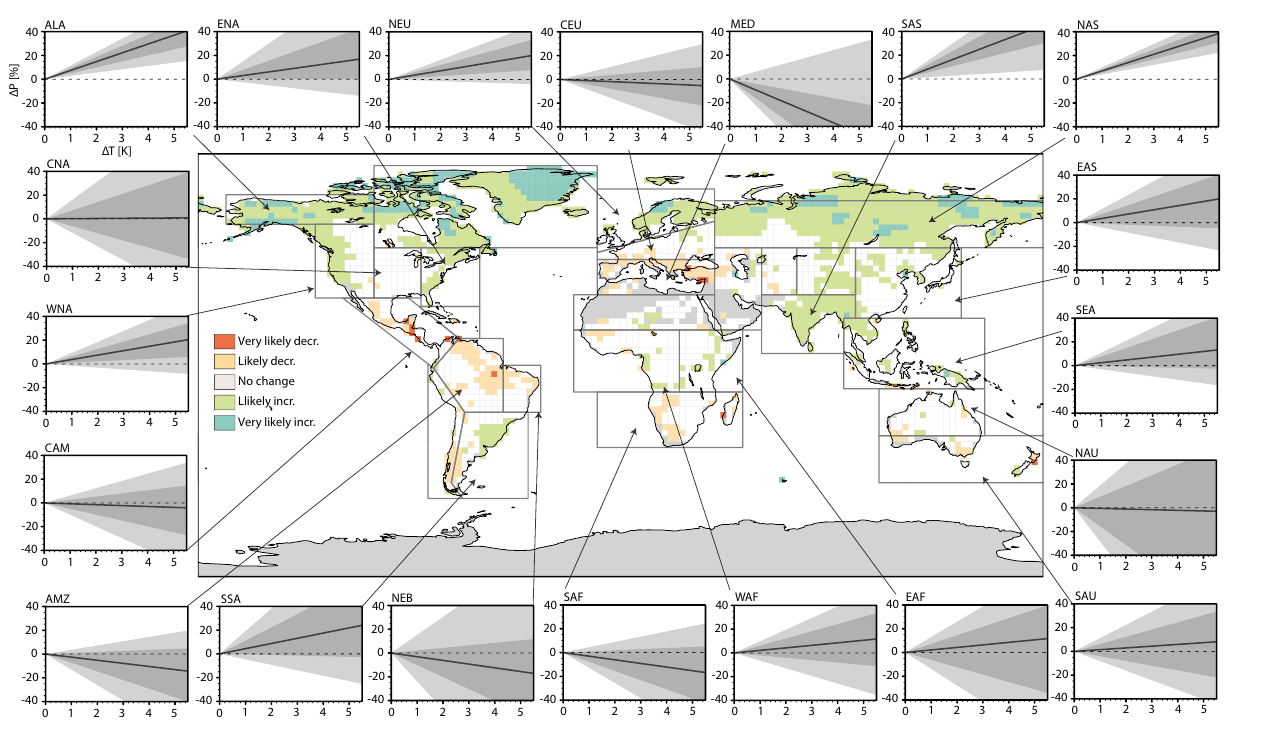
Figure 4. Conceptual summary of the probability that the slope of P − E is negatively/positively different from zero considering all climate models and all scenarios. Panel plots show the uncertainty distribution of the sensitivity of P − E to global temperature change as a function of global mean temperature change averaged for each SREX region outlined in the map (the shading in each panel plot corresponds to those illustrated in Fig.